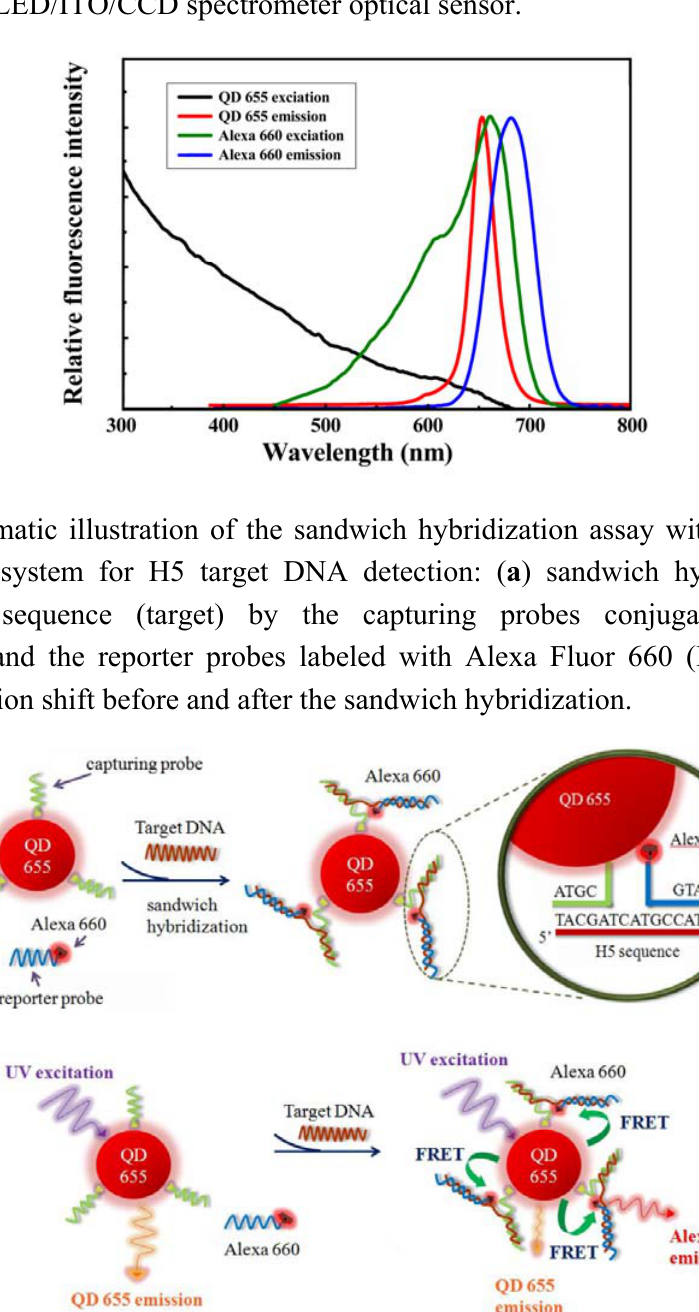
Figure 3. Comparison between the excitation and emission spectra of QD655 and Alexa Fluor 660. The emission maxima of QD655 and Alexa Fluor 660 occur at 653 and 690 nm, respectively. The excitation spectra were measured by the lab-grade